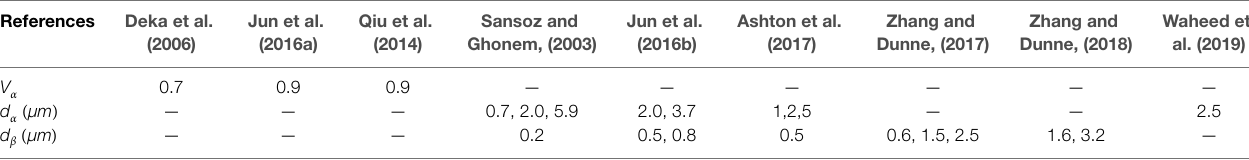
TABLE 1 | Measured values of the microstructure geometry parameter for Ti-6242 available in the literature.